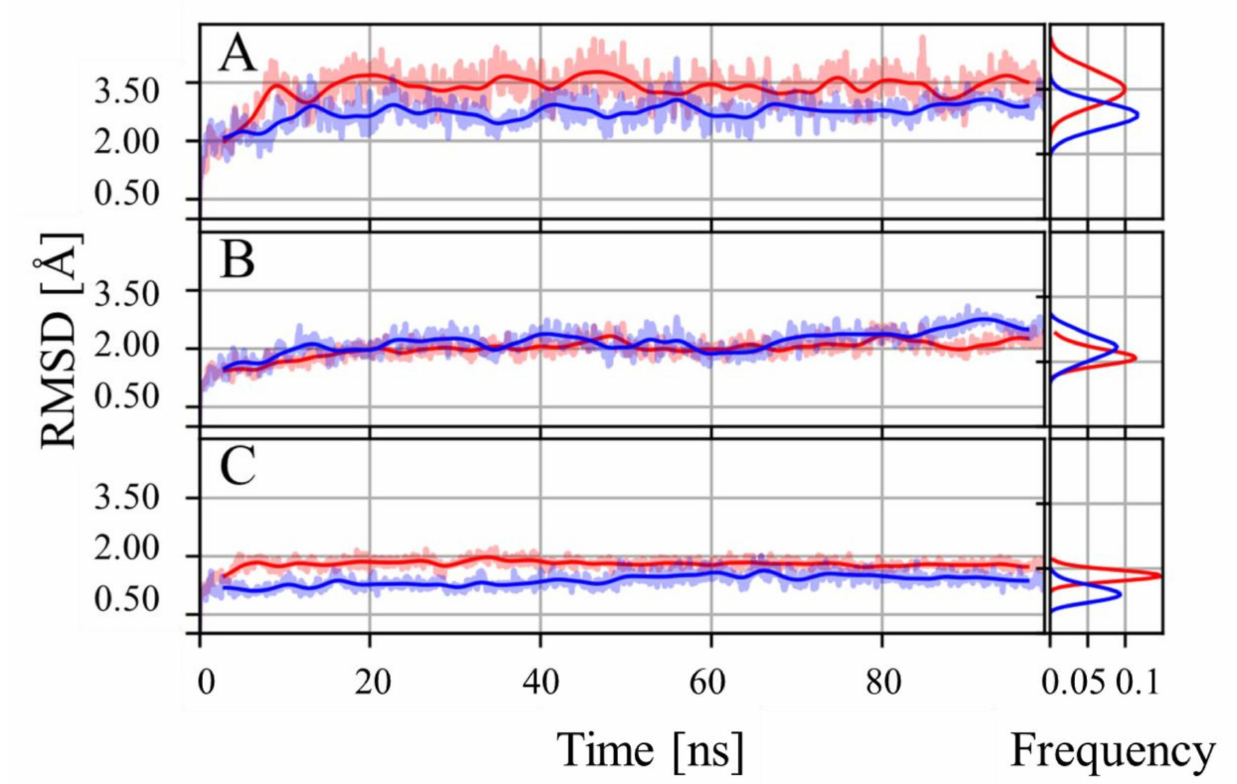
Figure 1. RMSD throughout 100 ns of MD simulation. Alpha carbon RMSD computed over the whole complex ( A ), hACE-2 receptor ( B ) and RBD of spike protein ( C ) from the wild type (blue) and gamma variant (red) simulated complexes. Bold continuous lines represent the weighted moving average over the original RMSD data (standard gaussian kernel with 30 frame window). The associated colored shadows correspond to the original RMSD data. RMSD histograms presented on the right end of each plot collect information starting at 20